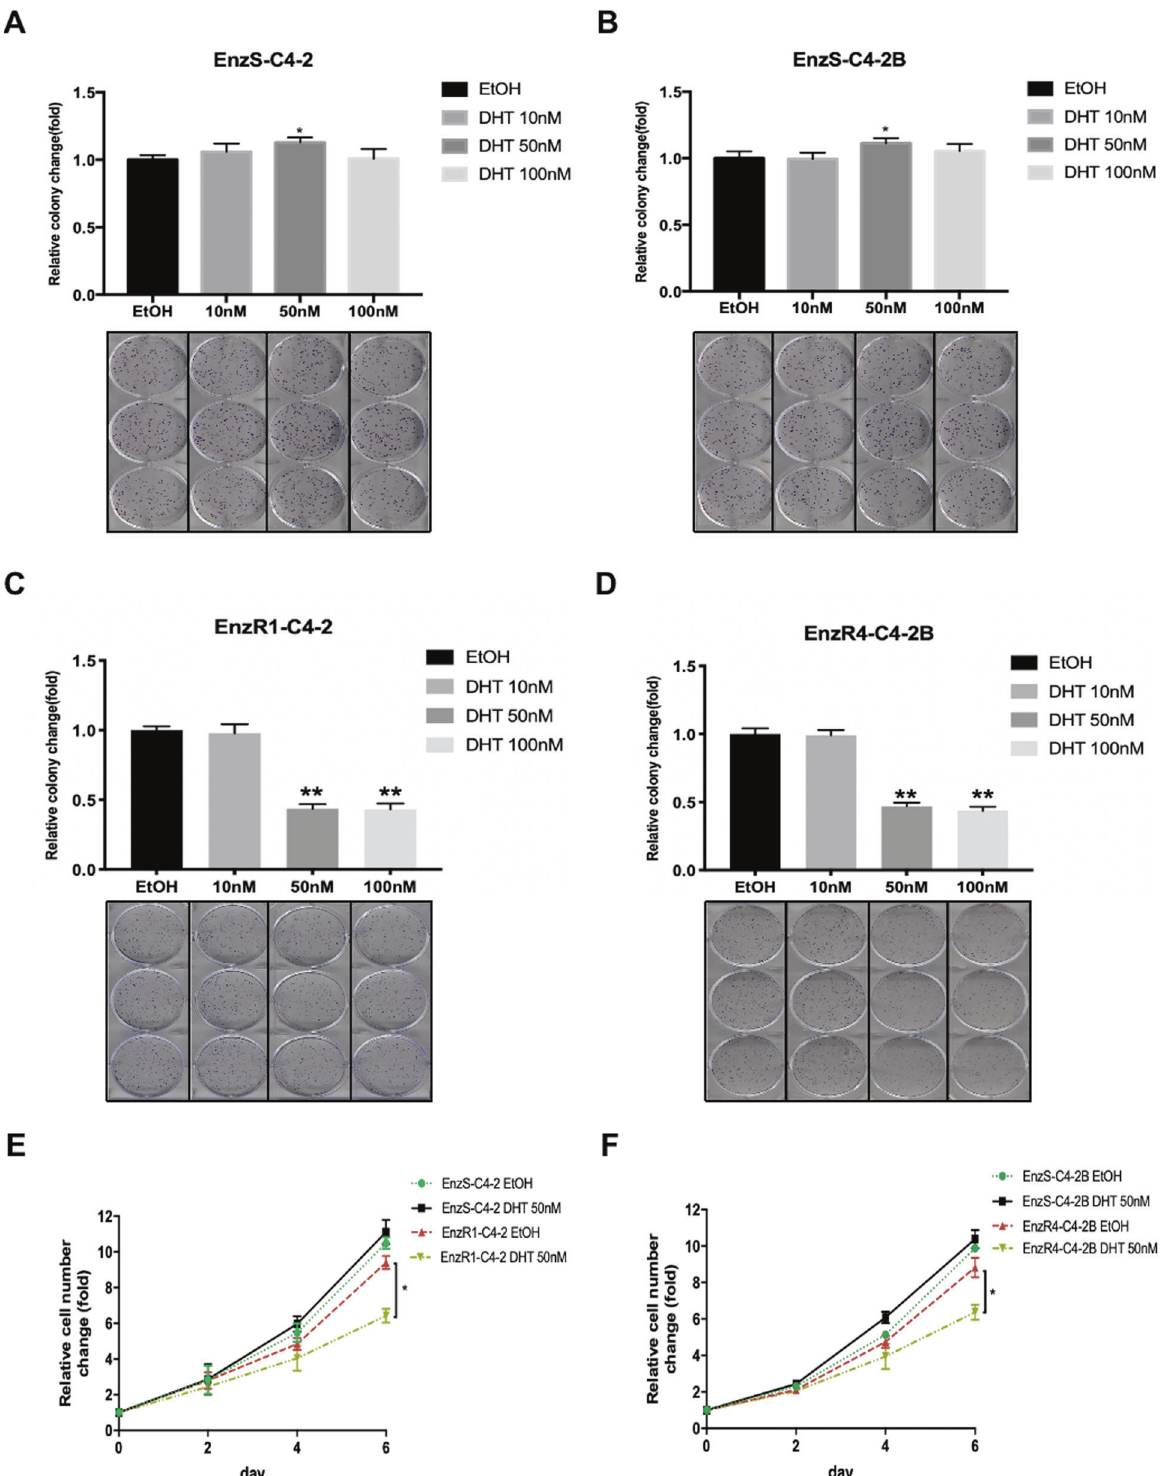
Fig. 1 DHT can inhibit Enzalutamide-resistant PCa cells growth. A – D DHT could affect MTT assays, therefore colony formation assays were performed to show EnzS1-C4-2 ( A ) EnzS4-C4-2B ( B ), EnzR1-C4-2 ( C ), and EnzR4-C4-2 ( D ) cells growth with different concentrations of DHT. E , F Cell counting assays to show cell proliferation in EnzS vs EnzR cells (C4-2 and C4-2B) treated with EtOH or 50 nM DHT. Data are presented as means ± SD. * p < 0.05, ** p < 0.01.